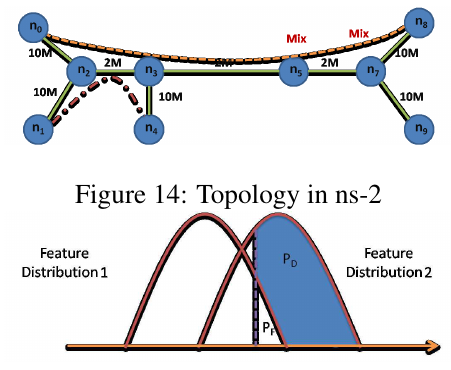
Figure 15: Calculation of P D and P